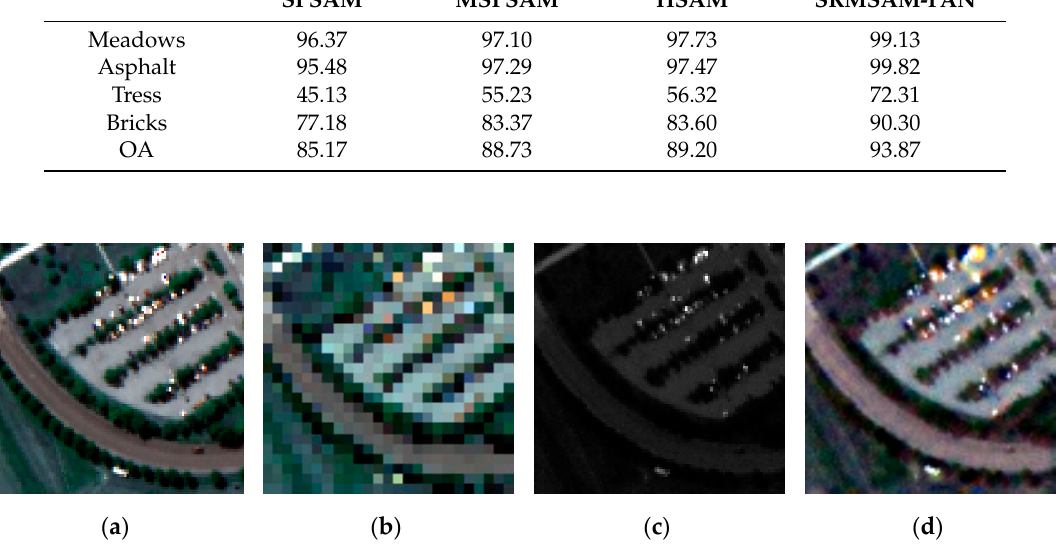
Table 1. Mapping accuracy (%) of the four methods ( S = 4).